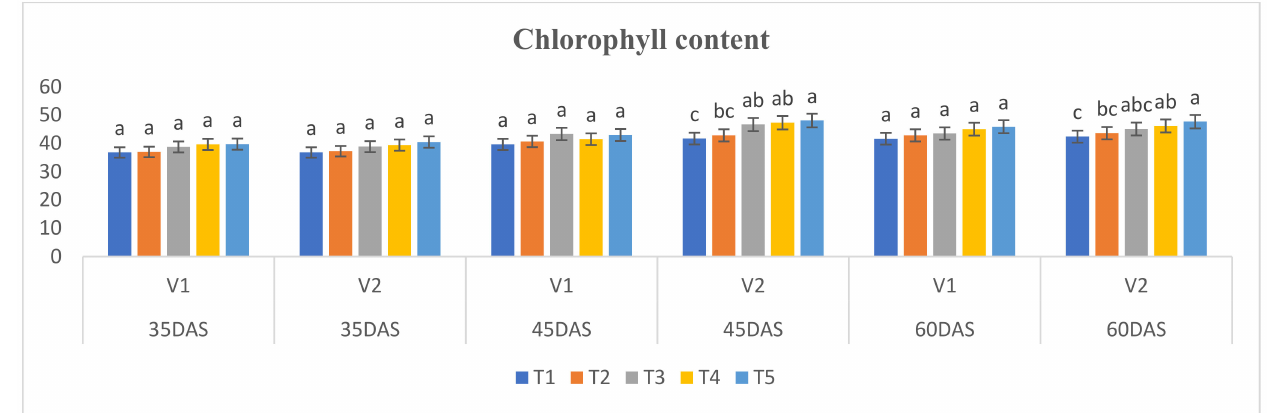
Figure 6. Effect of hydro, Mg(NO 3 ) 2 , ZnSO 4 , Mg(NO 3 ) 2 + ZnSO 4 primed and nonprimed (control) seed treatments on chlorophyll content of wheat varieties, grown in the year 2017–2018. The full description of abbreviations T1, T2, T3, T4, T5, V1 and V2 are represented in material and methods section. Lowercase alphabetical letters (a,b,c) represents the significant differences between the different seed priming treatments (Tukey test; p <